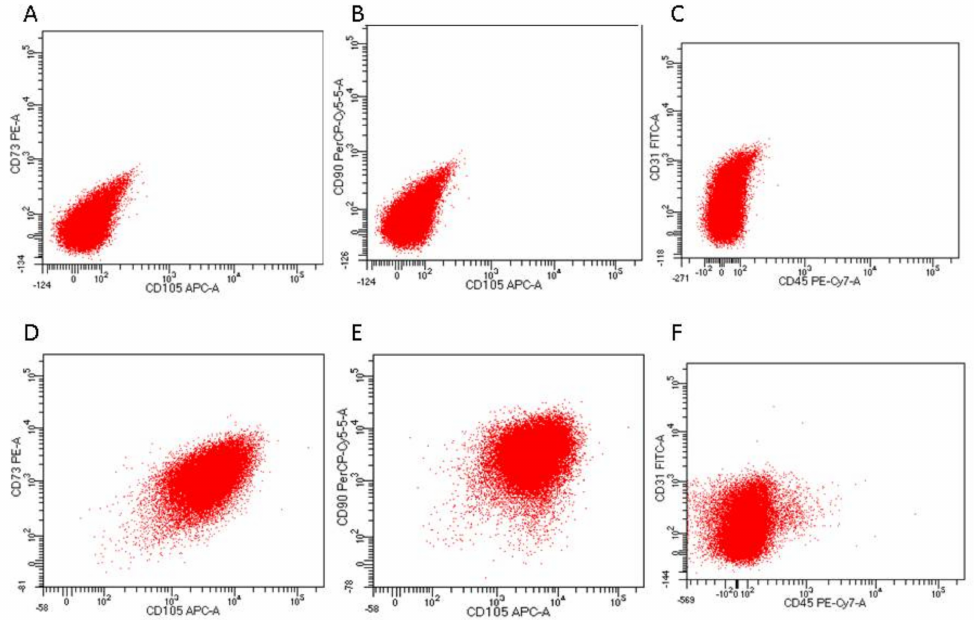
Figure A1. Characterisation of adipose tissue-derived MSCs. Flow cytometry analysis showed that unstained MSCs were negative for ( A ) CD73, ( B ) CD105, CD90, ( C ) CD31, and CD45. Stained MSCs were positive for ( D ) CD73, ( E ) CD105, CD90, and negative for ( F ) CD31,